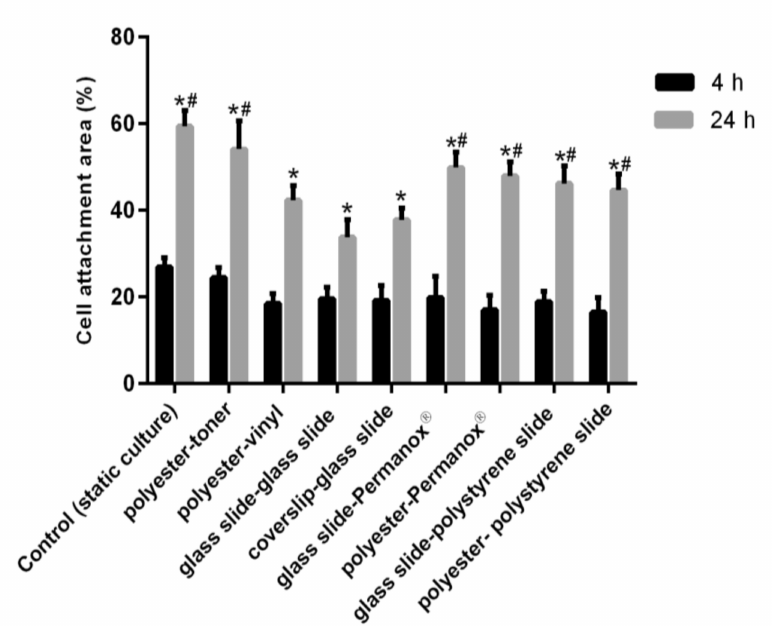
Figure 8. Biocompatibility of all microchips measured by the cell attachment area, which is the percentage occupied by the cells of the total area of the channel. Significant difference * p < 0.01 against 4 h. # p > 0.05 no significant difference among the control, polyester-toner, glass slide- Permanox ® and polyester-Permanox ® microchips in 24 h.